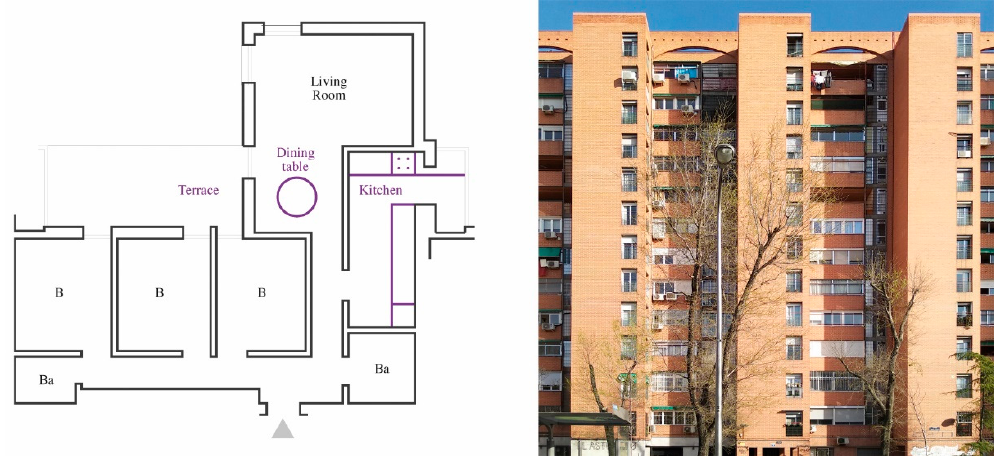
Figure 5. IVIMA residential building in Palomeras Sureste, UV 1 Block. Three-bedroom apartment. Plan redrawn and photo by author.